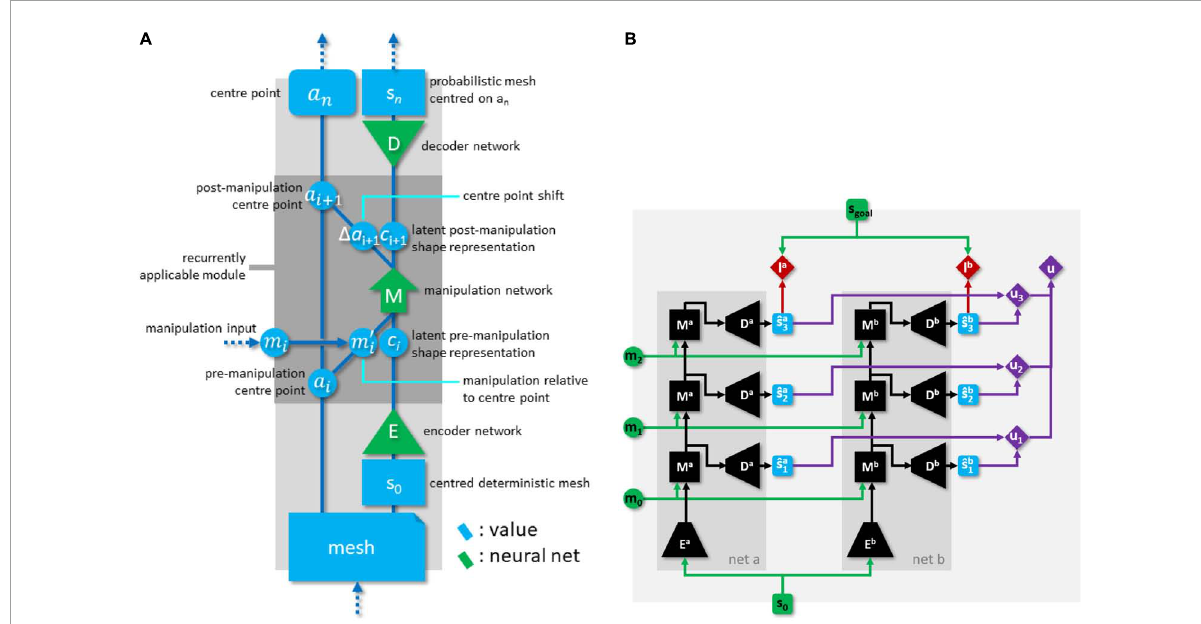
FIGURE4 (A) Global structure of the pEM*D net. (B) Dual network architecture with explicit epistemic uncertainty penalty, rolled out for 3-step plans. Green items indicate network inputs and (externally supplied) goal state. Black items are neural network modules. Blue items are state predictions. Red items are losses. Purple items comprise the epistemic uncertainty penalty